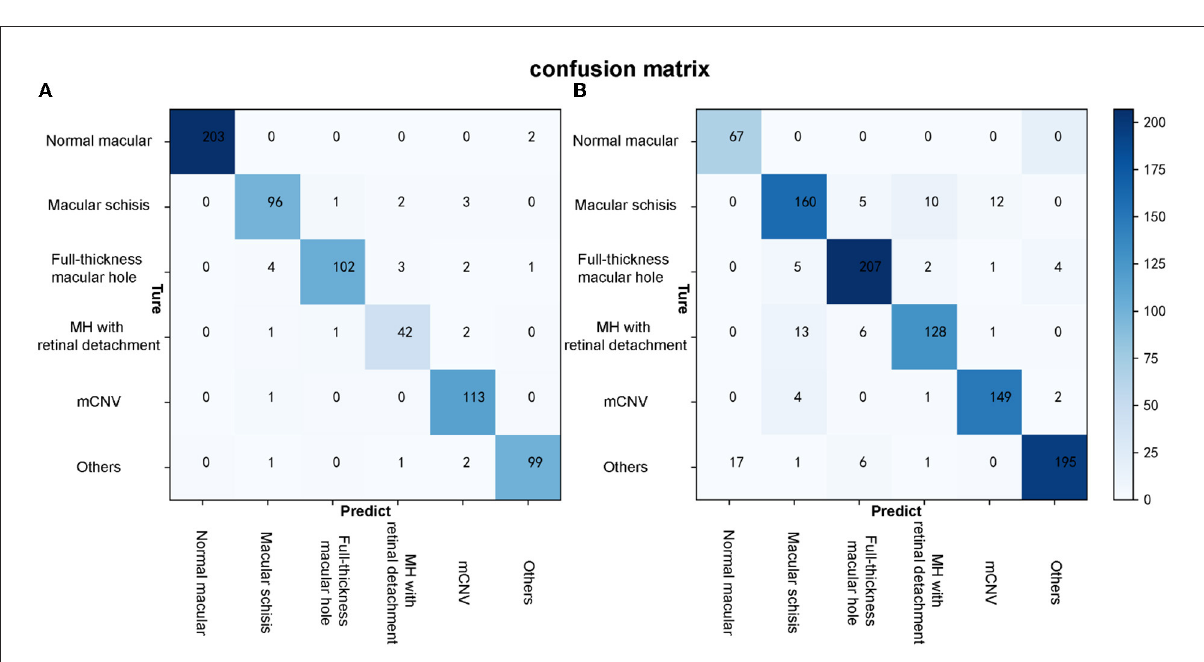
was 99.65% (95% CI: 0.992, 1.000); AUC for MH with Retinal detachment was 0.988 (95% CI: 0.983, 0.993), sensitivity was 91.30% (95% CI: 0.892, 0.934) with a specificity of 99.06%